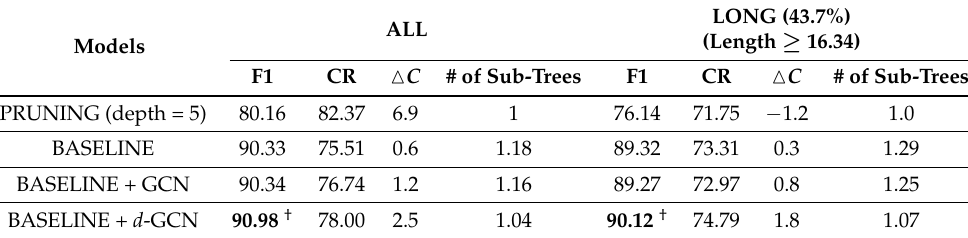
Table 2. Evaluation results for Korean sentence compression. † indicates that the difference of the F1 score from the BASELINE is statistically significant with 0.95 confidence. We used paired-bootstrap- resampling [13] with 14,605,000 random